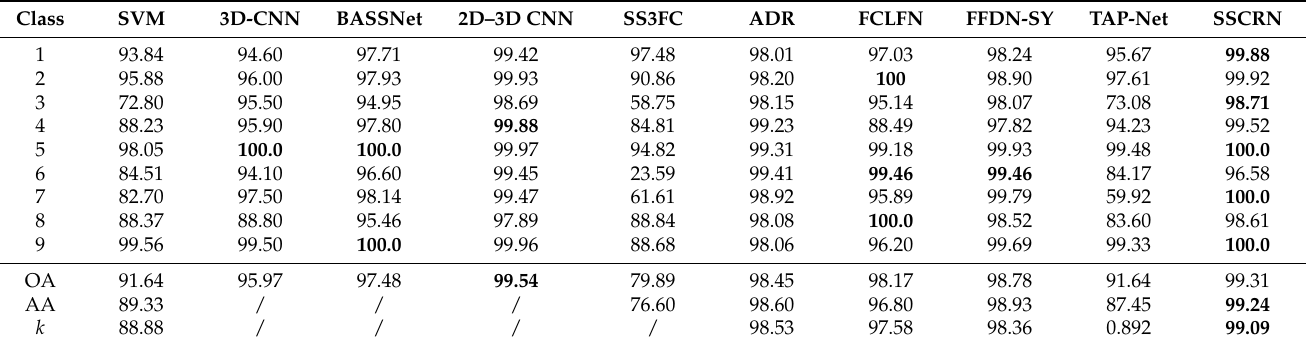
Table 9. Classification results (%) of different methods on the PU dataset. Bold indicates the best accuracy.